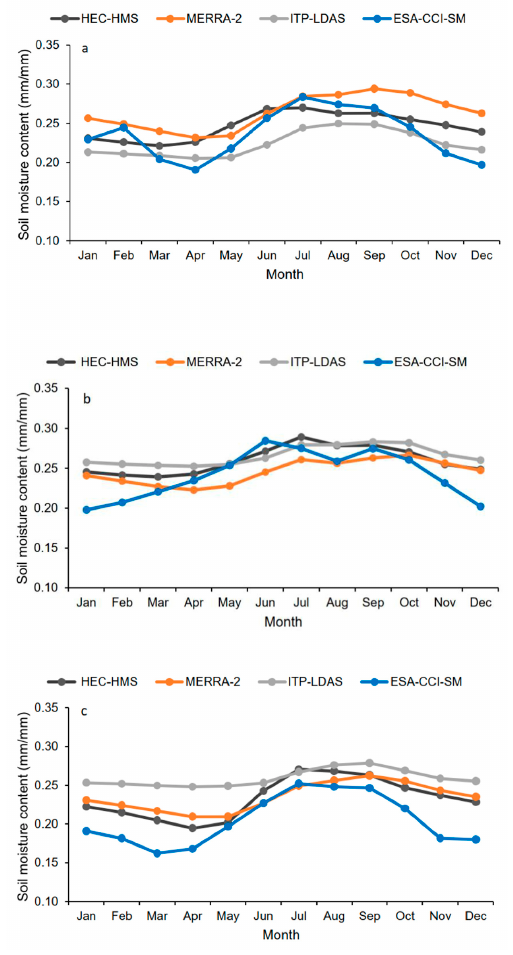
Figure 8. Comparison of soil moisture content simulated by HEC-HMS with ESA-CCI, MERRA-2, and ITP-LDAS data in ( a ) the SLR, ( b ) SYER, and ( c ) SYAR.